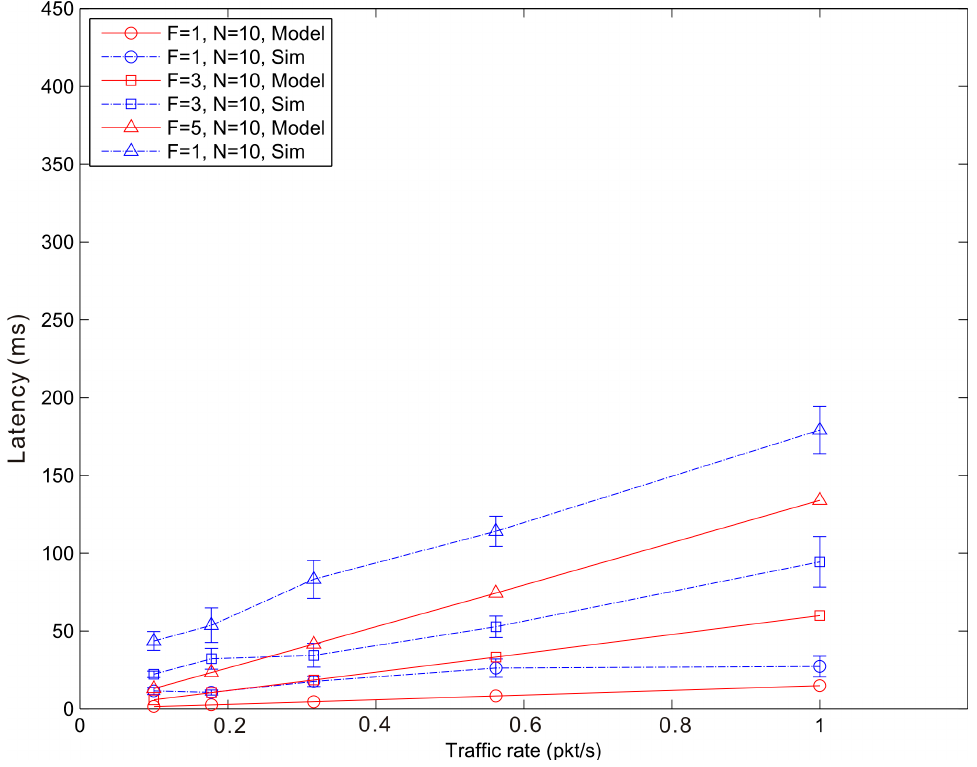
Figure 17. 6LoWPAN Fragmentation Latency versus traffic rate for a star topology network composed by 10